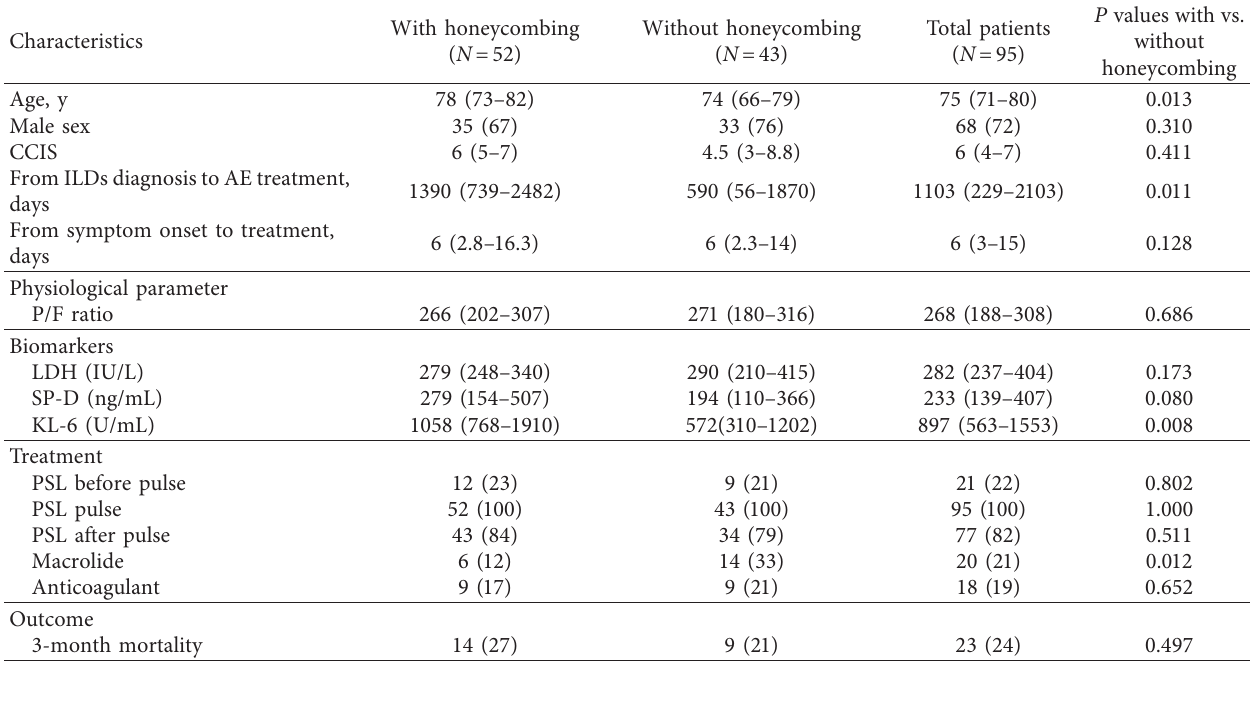
Table 3: Clinical comparison of patients with and without honeycombing.